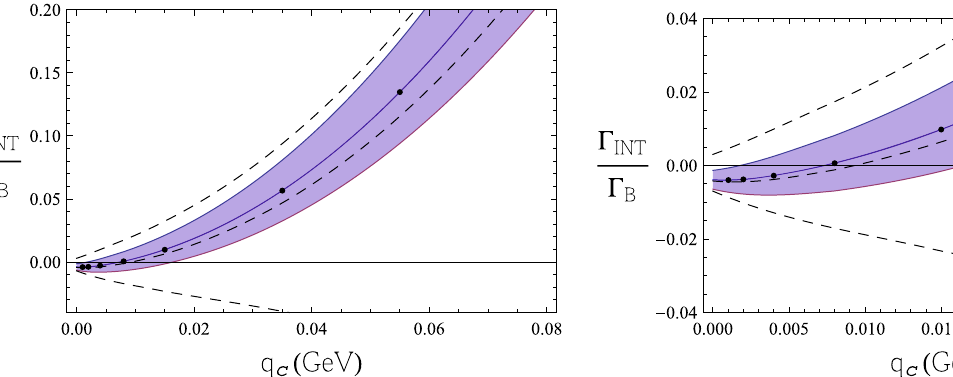
off the counterterms one at the time. The upper, central and lower lines ( 0 ) = 0, N ( 1 ) = 0 and N ( 2 ) = 0, respectively. The corresponds to N E E E right panel is a blown-up version of the left one for low q